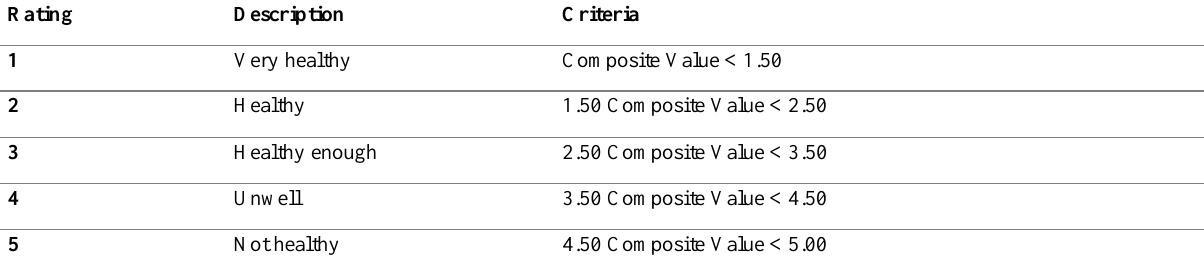
Table 1: Composite Rating Weights for Good Corporate Governance